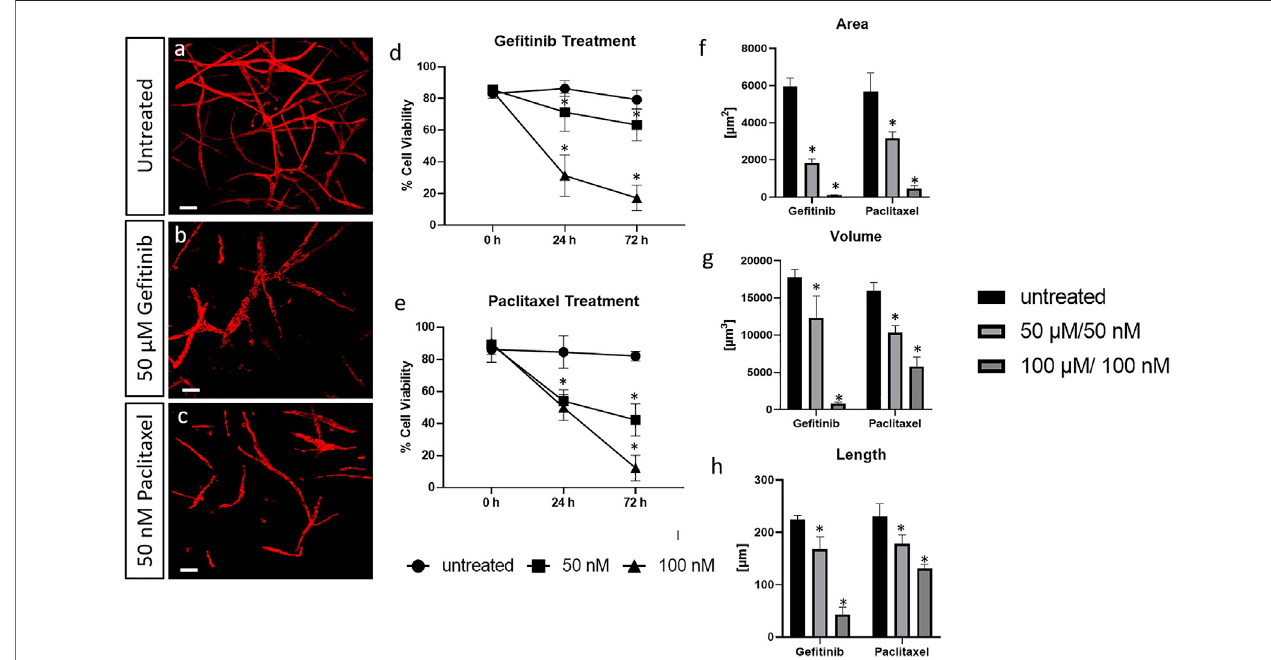
FIGURE 6 | CD31-stained HUVECs (red) in tri-cultures under hypoxic culture conditions (A) after treatment with 50 µM ge fi tinib and 50 nM paclitaxel for 72 h (B) and (C) , respectively; TPLSM images). Scale bar: 50 µm. Cell survival assay of tri-cultures in 3D after treatment with different doses of ge fi tinib and paclitaxel (D, E) . Statistical evaluation of theparameters:area ofthevascular structures (F) ,volume (G) and total length ofthe structures (H) . Statistical signi fi cance isprovided with *and shows the signi fi cance of the individual values for p < 0.05.